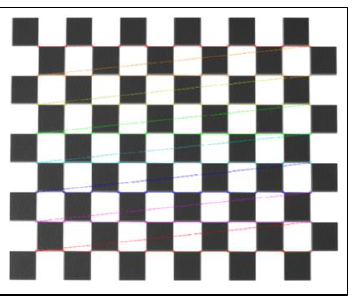
Figure 4. Checkerboard grid calibration